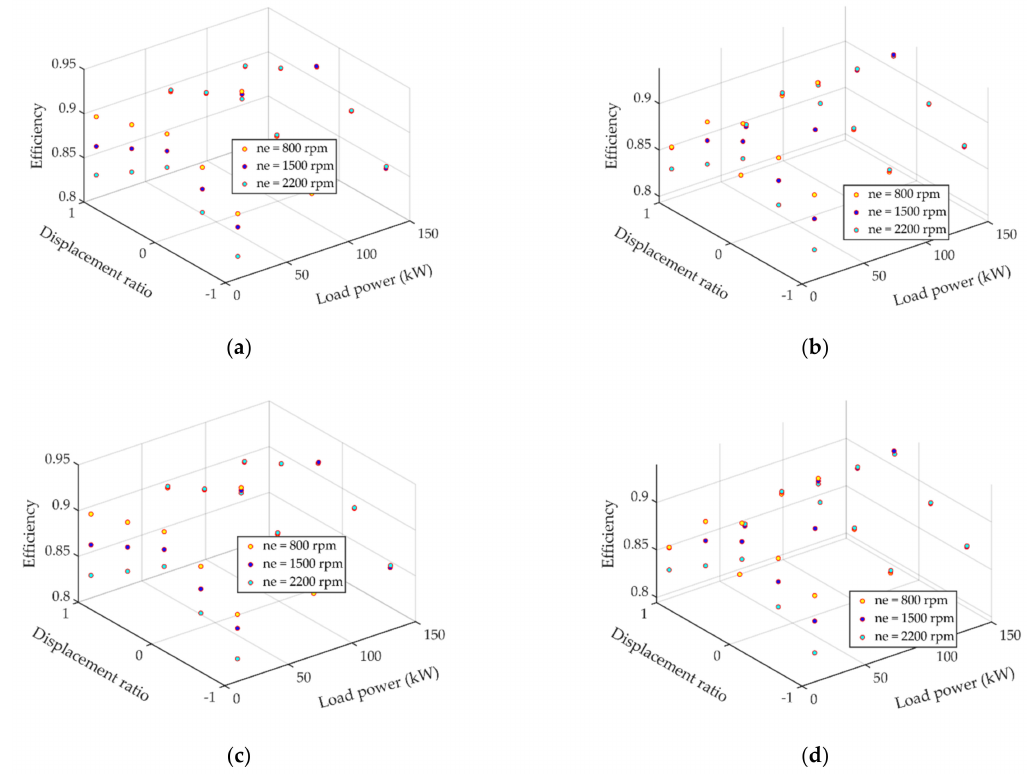
Figure 5. Measurement results of full factorial test for HMCVT transmission efficiency. ( a ) Stage HM 1 ; ( b ) stage HM 2 ; ( c ) stage HM 3 ; and ( d ) stage HM 4